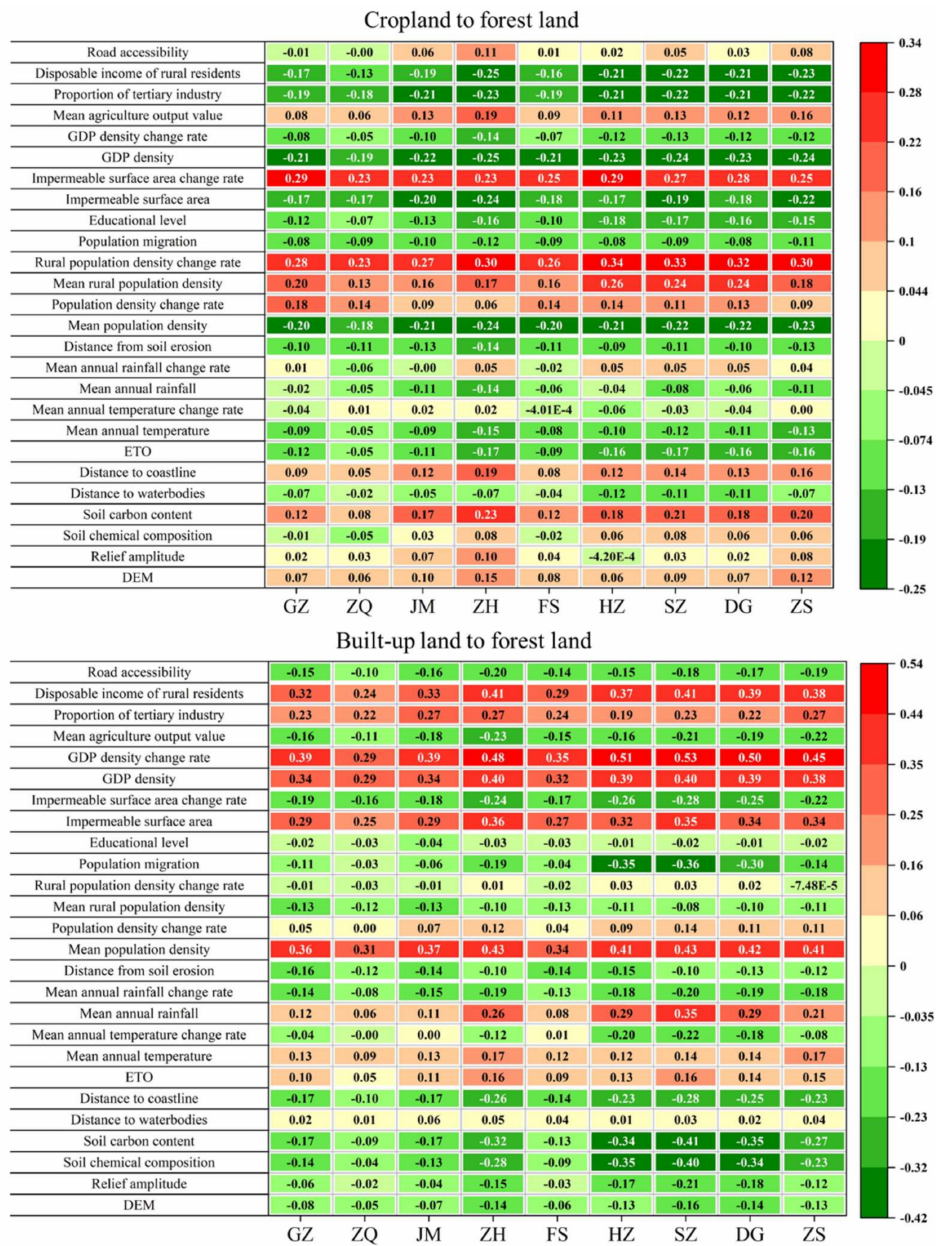
Figure 6. The Geographically weighted regression coefficient of each factor in different cities for afforestation. The numerical value represented the strength of the force. The redder the color, the stronger the positive effect. The greener the color, the stronger the negative effect. GZ: Guangzhou; SZ: Shenzhen; ZH: Zhuhai; FS: Foshan; JM: Jiangmen; ZQ: Zhaoqing; DG: Dongguan; ZS: Zhongshan; HZ: